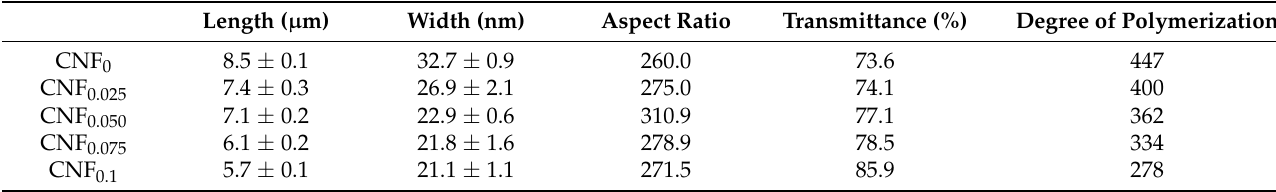
Table 2. Morphological characteristics of